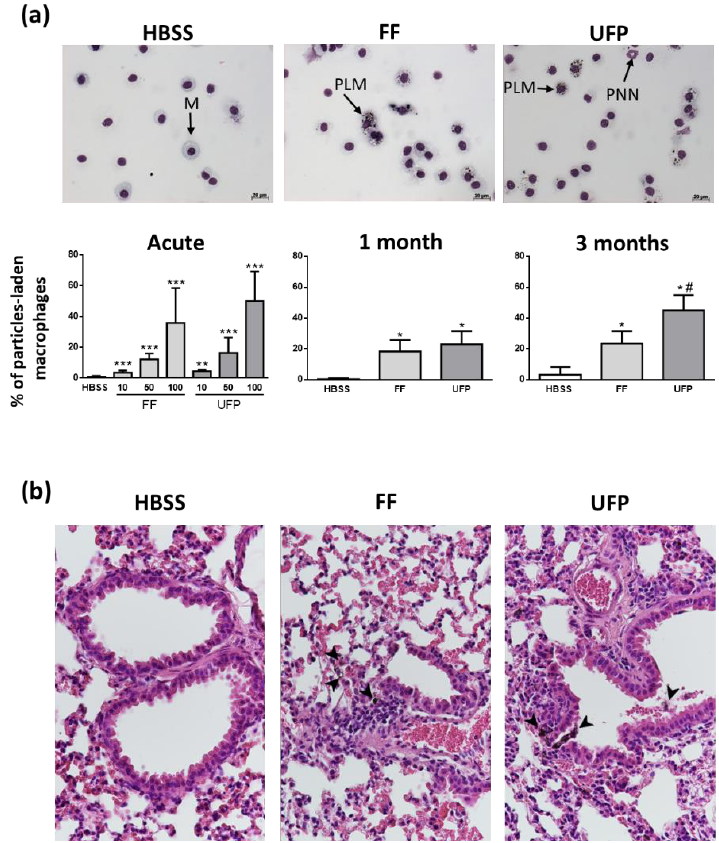
Figure 3. Internalization of particles in lungs. ( a ) Representative micrographs of BAL cells of mice exposed for three months and histogram showing BAL cell count of particle-laden macrophages; M = macrophage, PLM = particle-laden macrophage, PNN = Polynuclear Neutrophil. ( b ) Tissue micrographs of lung tissue (40×); Arrow heads point out particle-laden macrophages. * p ≤ 0.05 vs Control; ** p ≤ 0.01 vs Control; *** p ≤ 0.001 vs Control; # p ≤ 0.05 vs FF.